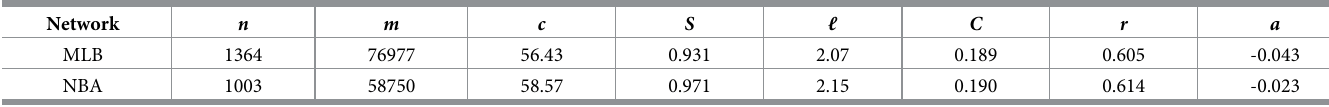
Table 13. Basic statistics for the MLB and NBA Twitter networks using mathematica. Network